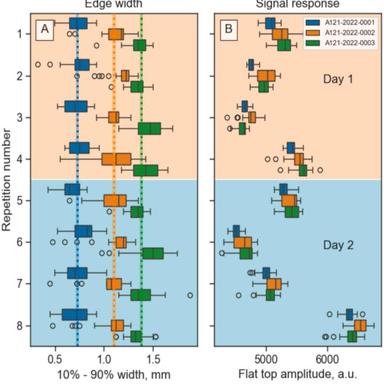
Reproducibility of image properties. Box plots showing the edge width (A) and signal response (B) of three depleted UO2 samples across eight different repetitions acquired over two consecutive days on a BAS imaging plate. Each box represents 25 profiles. While the edge width displays consistent results for each sample, the signal response varies between repetitions. Vertical colored lines in panel A visually represent the average of the eight repetitions for a specific sample, giving a clear and intuitive i